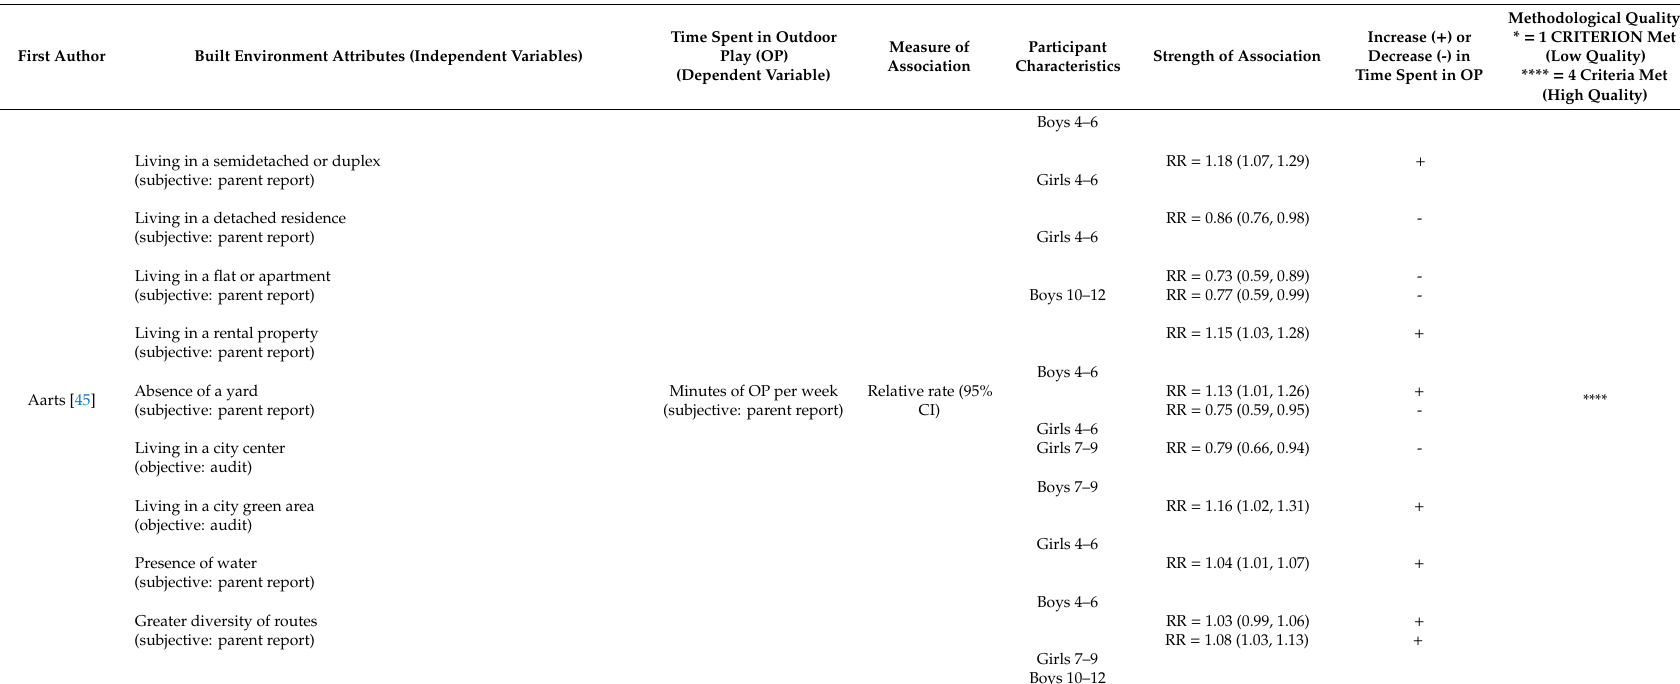
Table 3. Associations of built-environment measures with time spent in outdoor